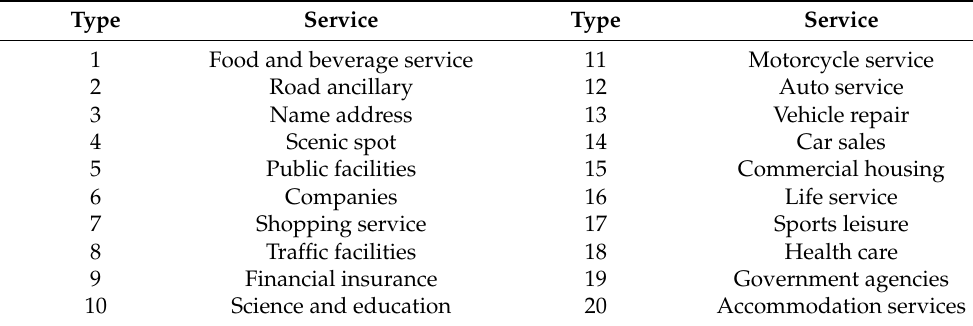
Table 2. Service types of Beijing POI dataset.